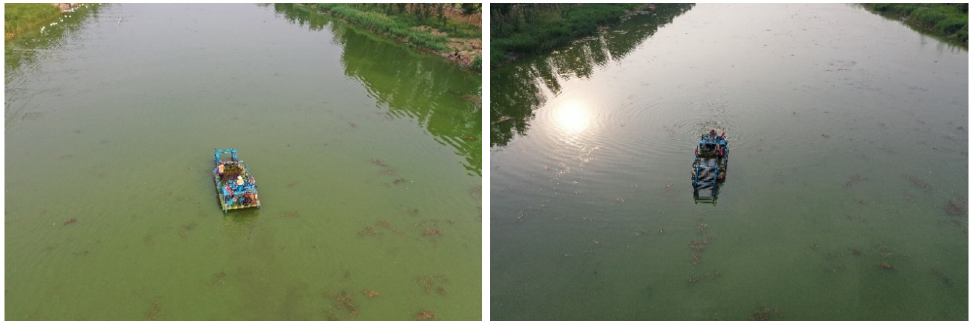
Figure 1. Salvage vessel for water surface waste inspection on the Longhe River.